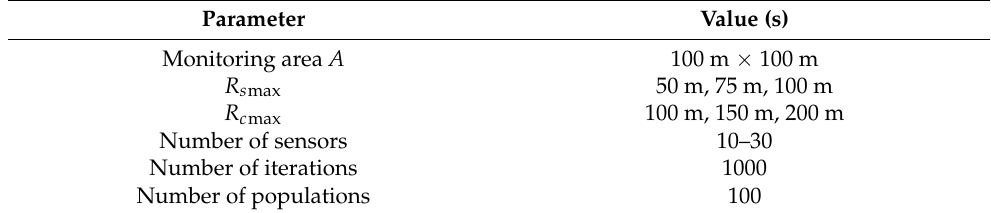
Figure 8. Terrain elevation values of the monitored area. Table 2. Simulation Parameters in area A.